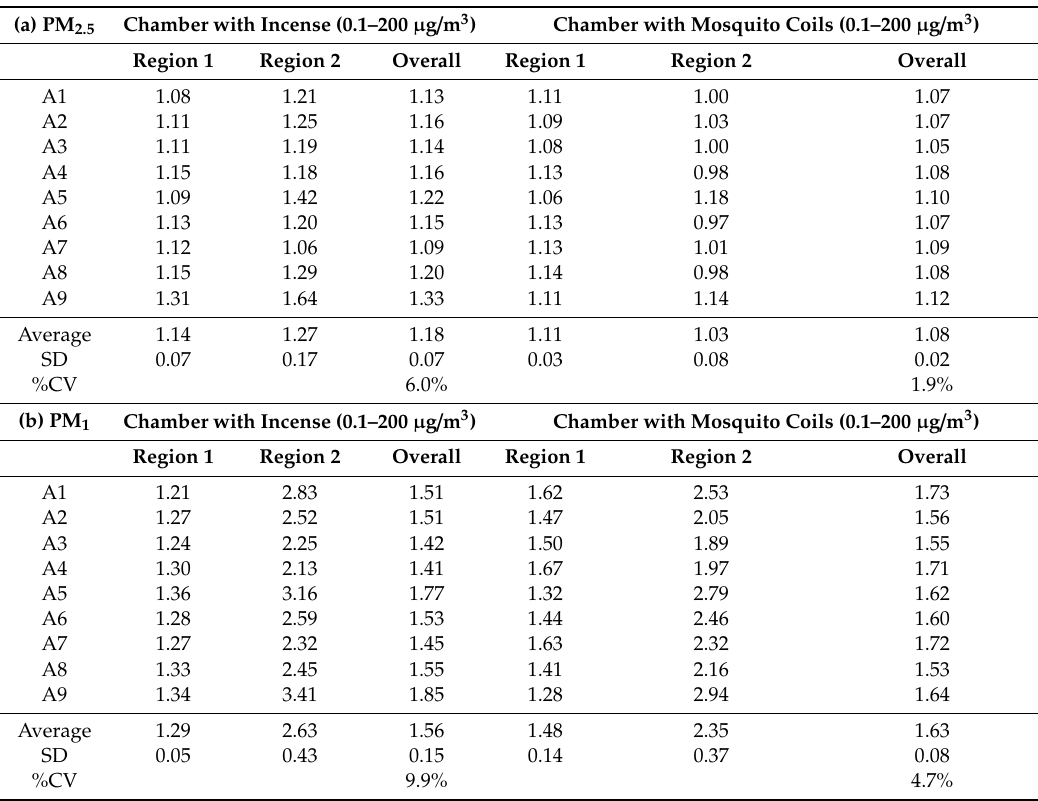
Table 4. Root mean square errors (RMSEs) of di ff erent regions based on the segmented regression equations from the chamber experiments with incense and mosquito coils for ( a ) 0.1–200 µ g / m 3